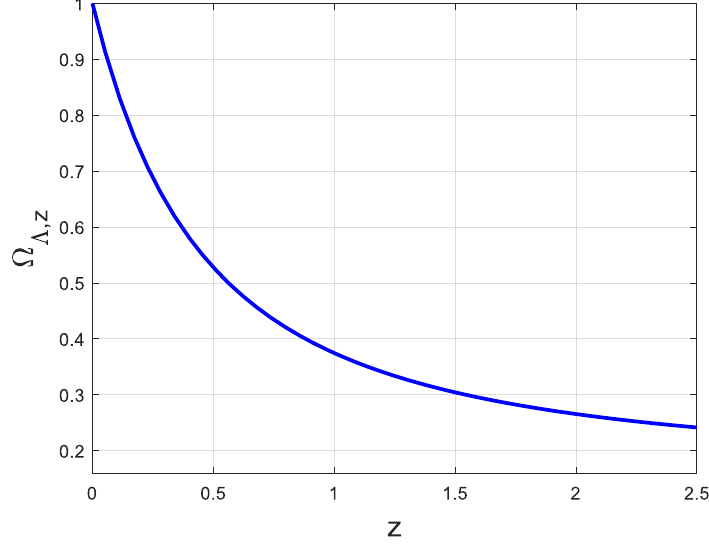
Ω Λ , z vs. the redshift z